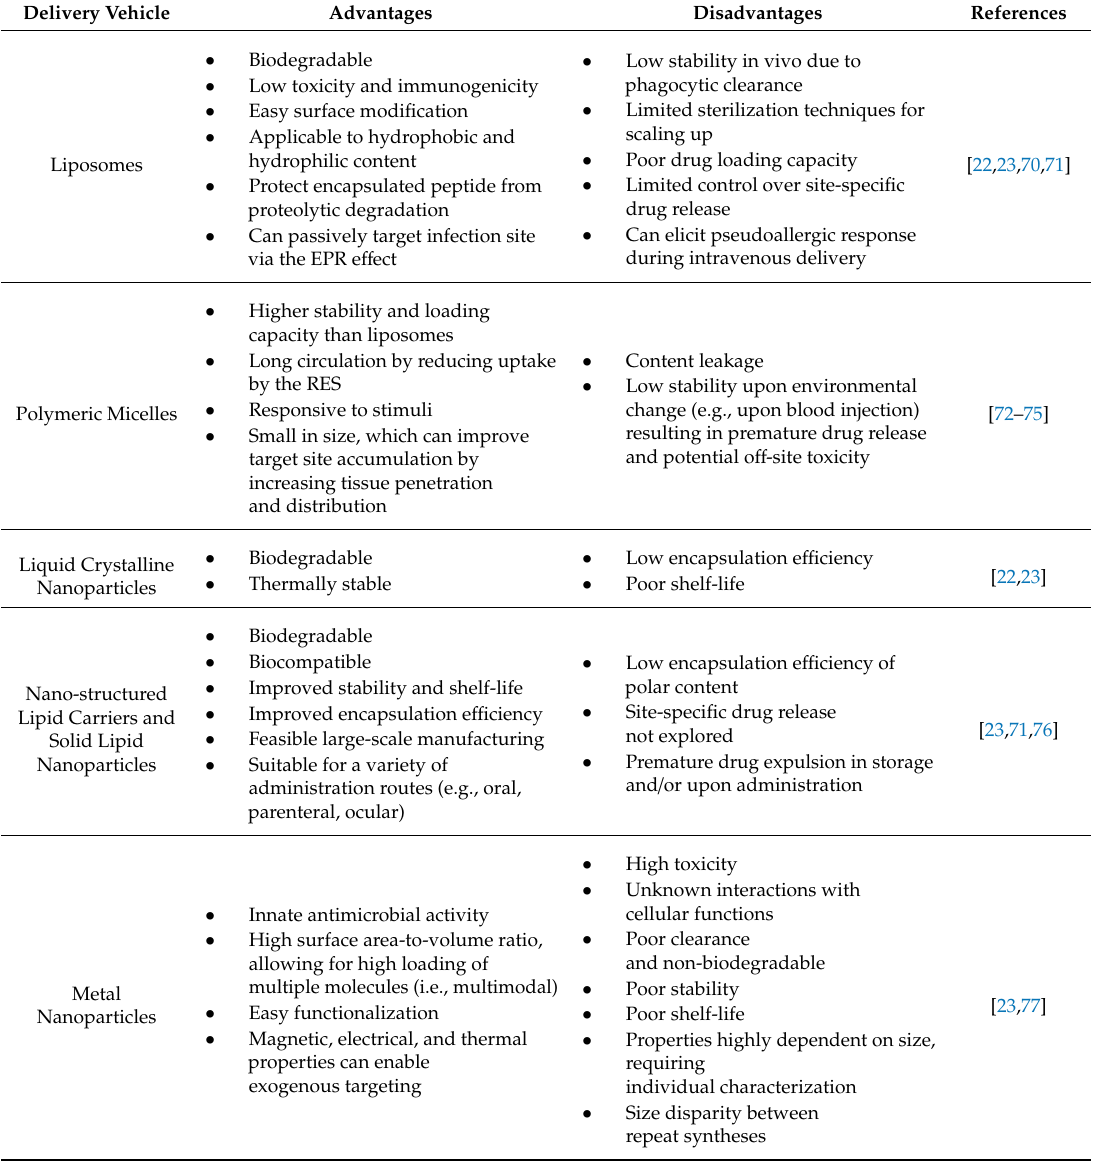
Table 1. Summary of the delivery vehicles discussed herein, as well as some of their advantages and